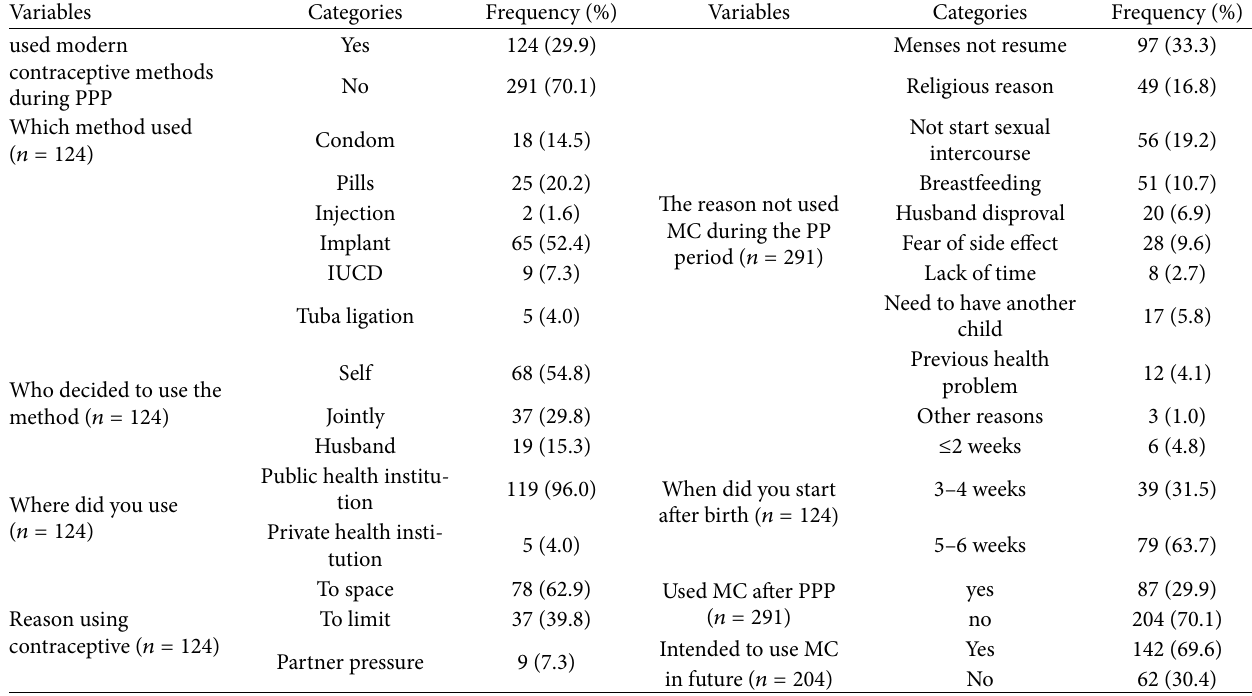
Table 4: Modern contraceptive use during PPP among mothers, in Sekota town and its Surroundings, Northwest, Ethiopia 2017 ( 𝑛 = 415 ) .